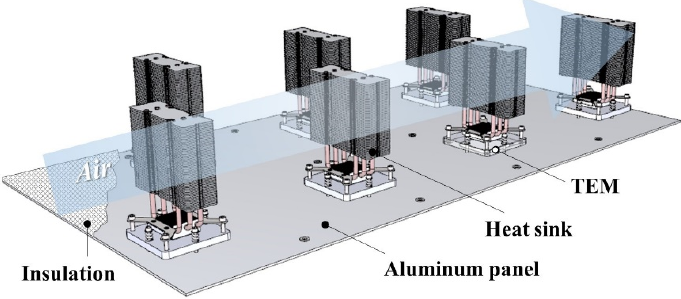
Figure 1. 3D diagram of the thermoelectric radiant panel.